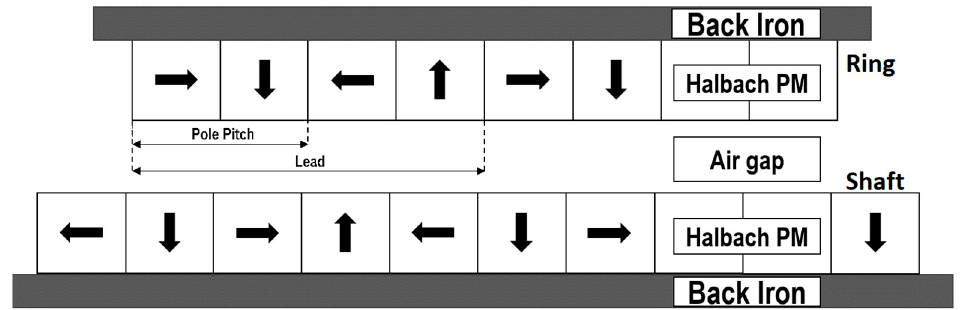
Figure 1. Halbach array MLA components and configuration (in 2D